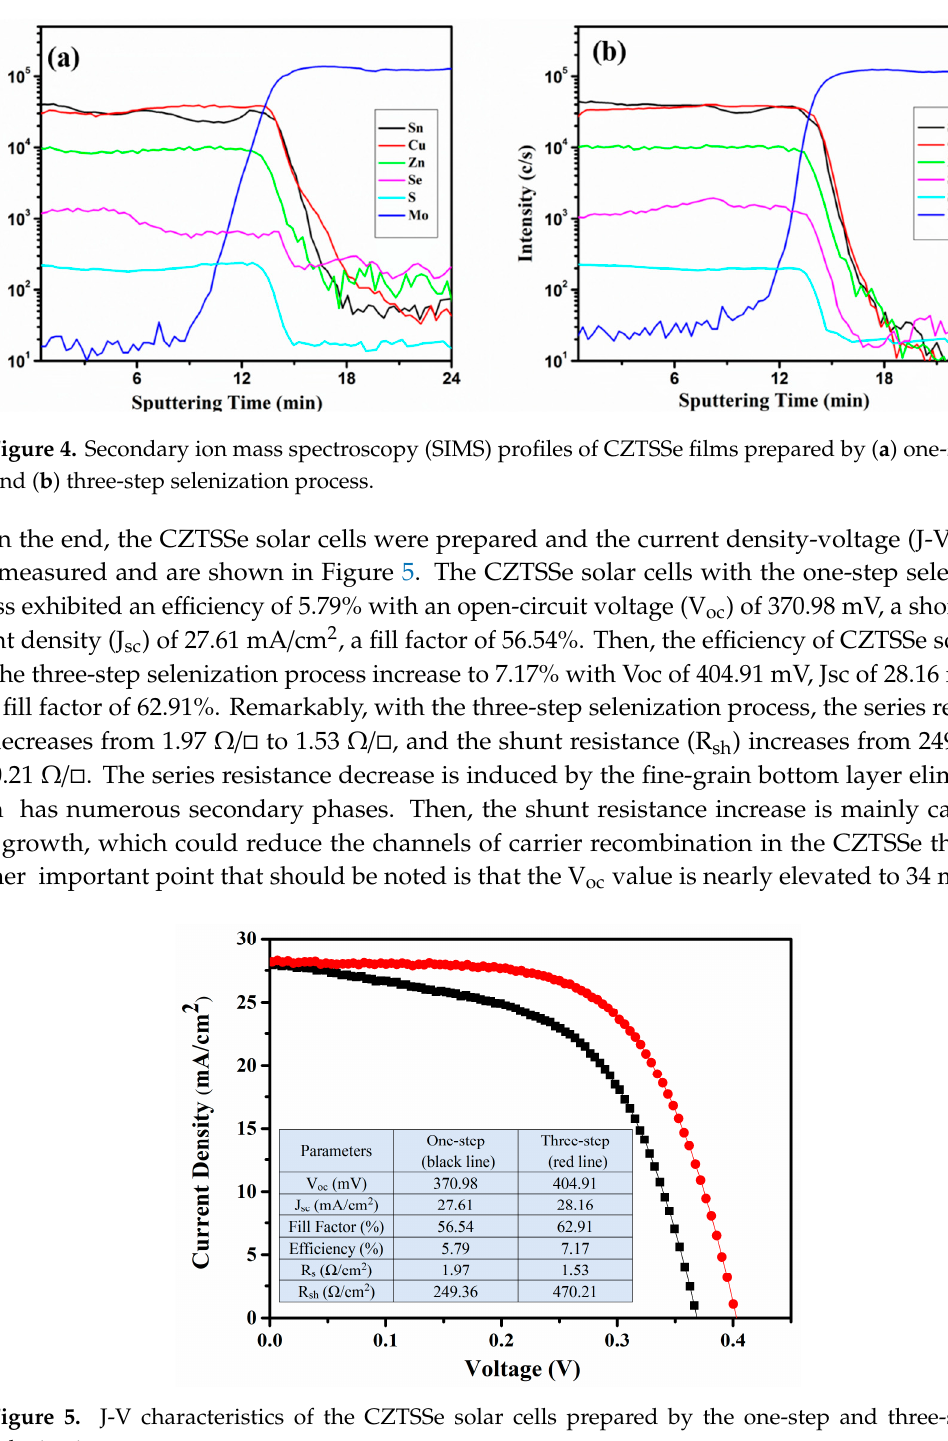
Figure 5. J-V characteristics of the CZTSSe solar cells prepared by the one-step and three-step selenization process.